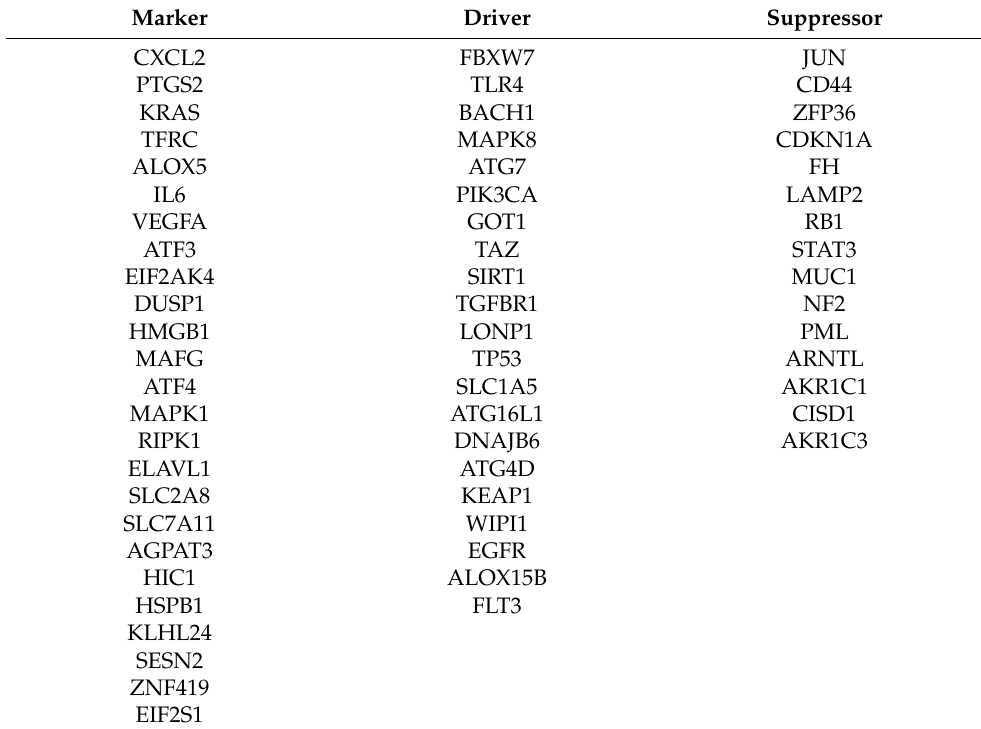
Figure 2. Venn diagram of DEGs from GSE27383 and ferroptosis-related genes. Table 1. Classification of these 61 common DEGs.